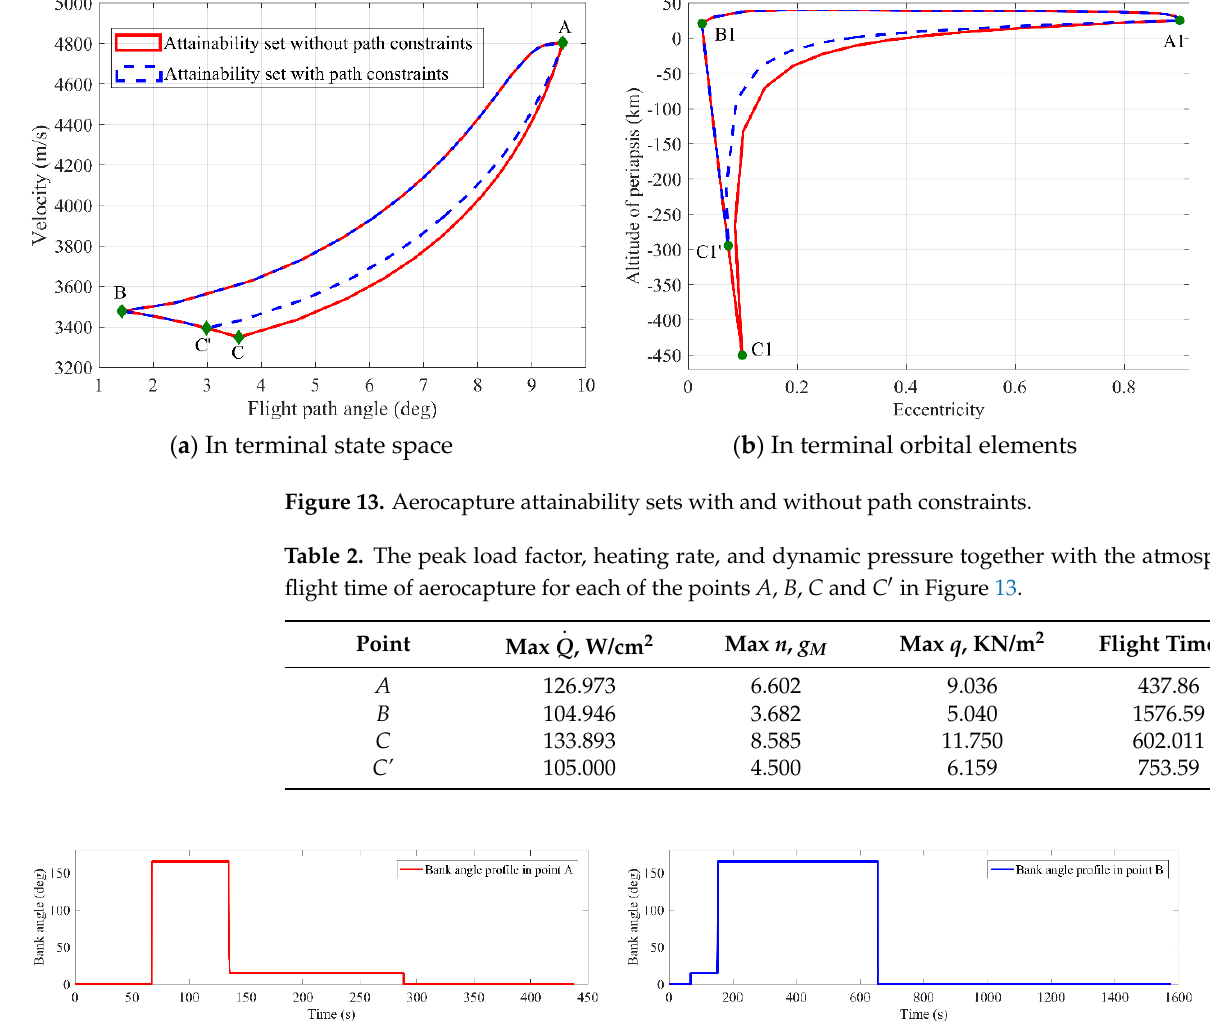
Table 2. The peak load factor, heating rate, and dynamic pressure together with the atmospheric flight time of aerocapture for each of the points A , B , C and C ′ in Figure 13.